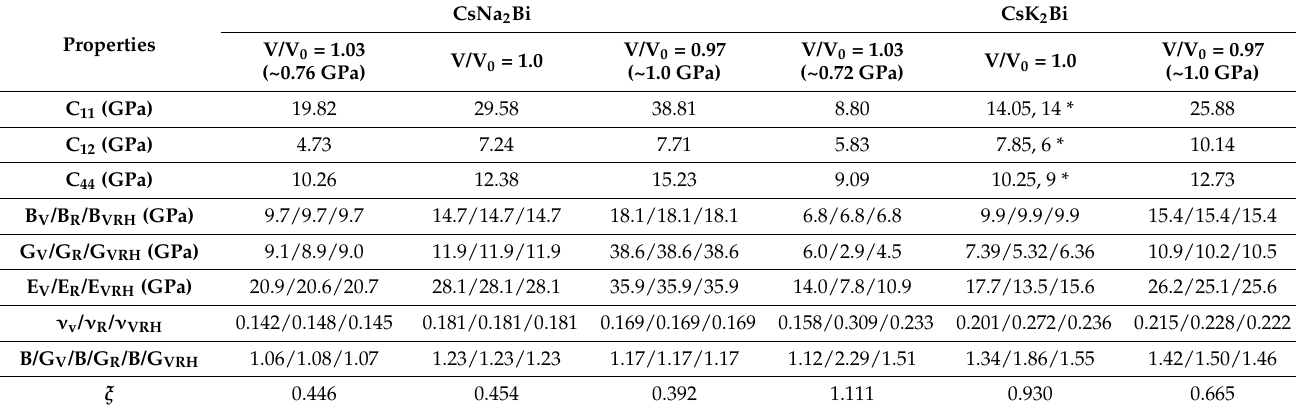
Table 1. Calculated elastic constants (Cij), bulk modulus (B), shear modulus (G), Young’s modulus (E), and Kleinman parameter ( ξ ) of Cs(Na, K) 2 Bi compounds under hydrostatic compression (V/V 0 = 0.97), tension (V/V 0 = 1.03), and equilibrium state (V/V 0 = 1.0). Voigt, Reuss, and Voigt–Reuss–Hill were utilized to calculate these moduli.